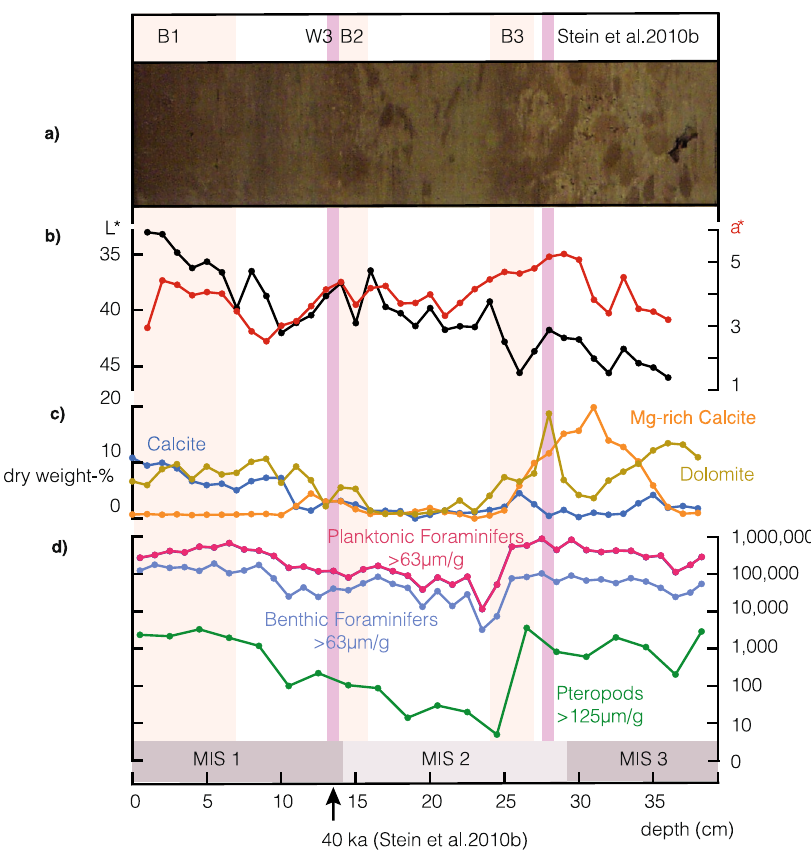
Fig. 9 Sediment characteristics core PS72/413-3. a Linescan image with published chronostratigraphic interpretation 51 . b Lightness L* and green-red color space a*. c Relative abundance of carbonates quanti fi ed from X-ray diffraction analyses of bulk sediments 94 . d Concentrations of planktonic and benthic foraminiferal and pteropod shells. MIS placement this